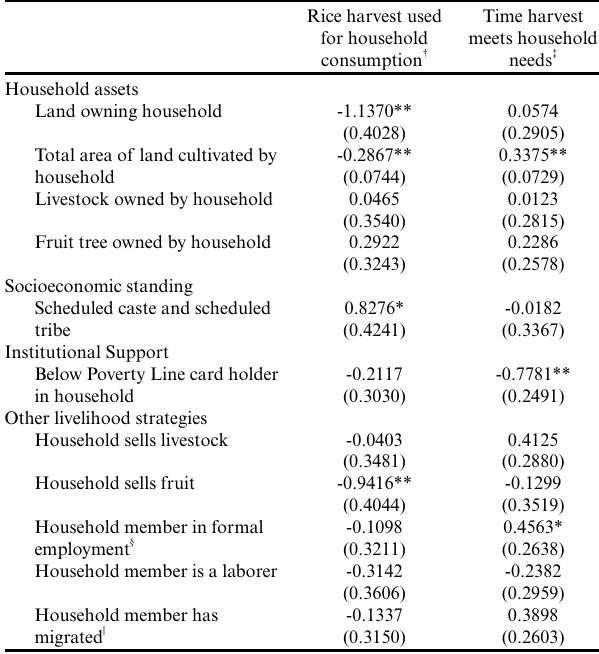
Table 3 . The effect (coefficient) of household asset levels, socioeconomic standing, access to institutional support, and partaking in other livelihood strategies on a household’s use of harvested rice and the length of time harvested rice met household consumption